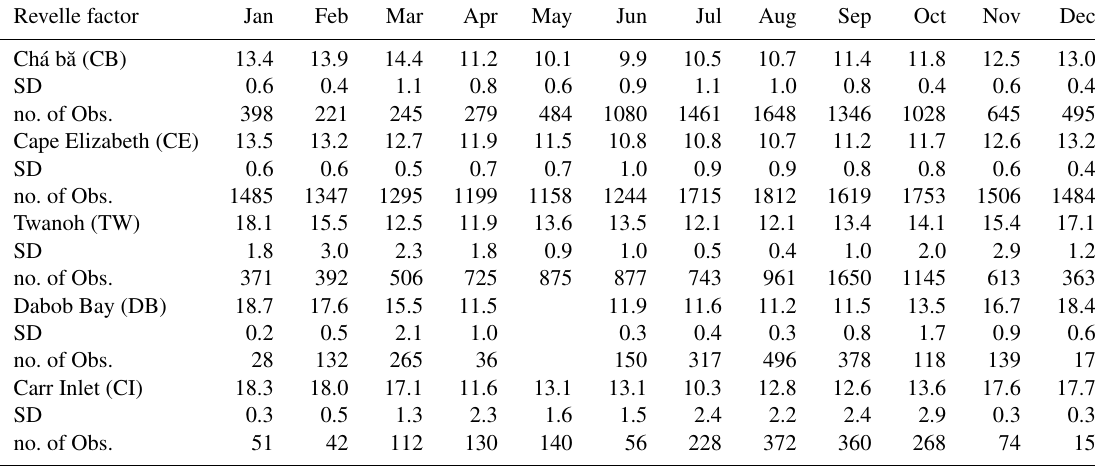
Table C8. Average monthly Revelle factor seasonal cycles for the five Washington State moorings with sufficient observations to estimate the Revelle factor. The average monthly standard deviation (SD) and total number of observations (no. of Obs.) contributing to the monthly average estimate are